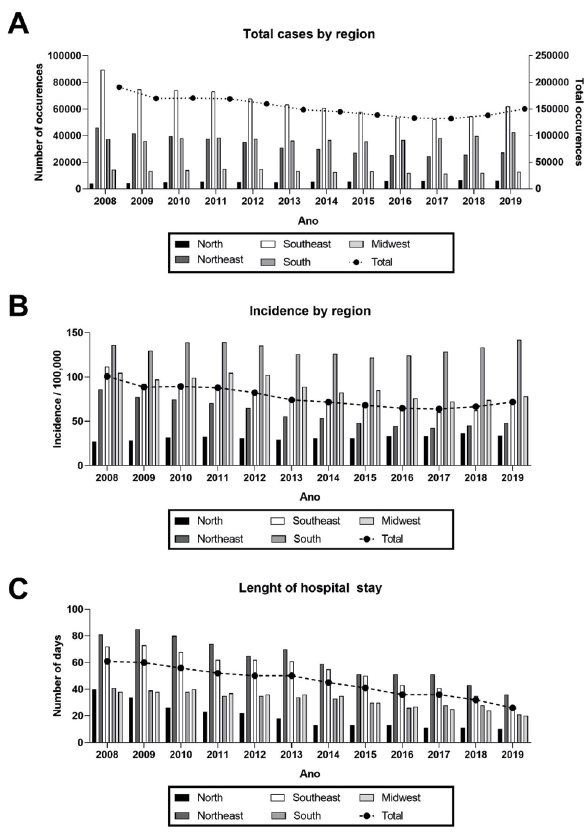
Figure 1. Total hospital admissions due schizophrenia and common mental disorders (A), incidence (B) and length of hospital stay (C) by region and year. Data for each region is plotted in the left Y axis, while total data (all regions combined) is plotted in the right Y